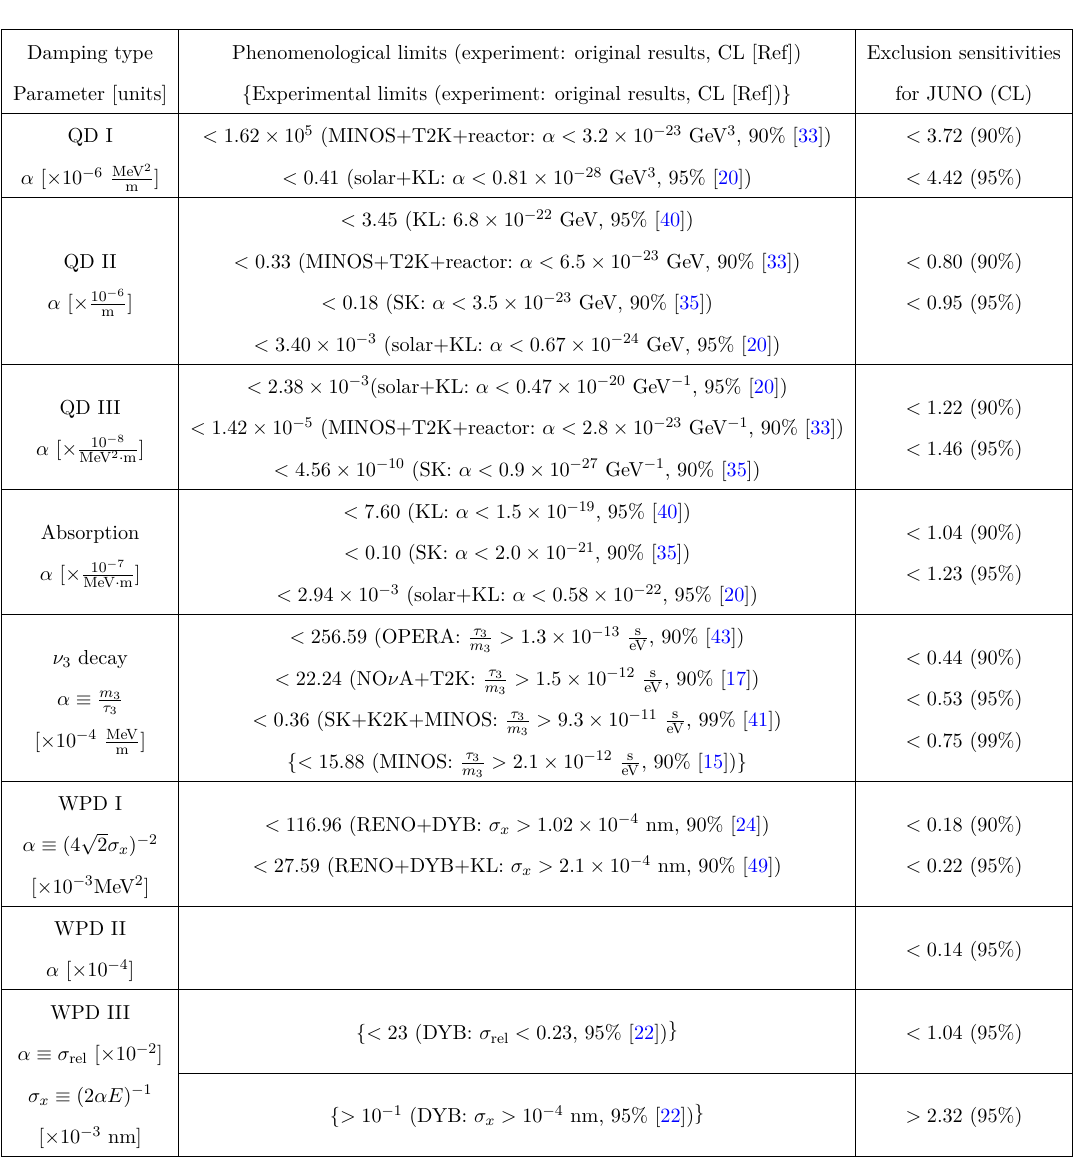
Table 3. The limits on the damping parameters for each damping model at JUNO. The experimental and phenomenological limits in the literature are also shown for